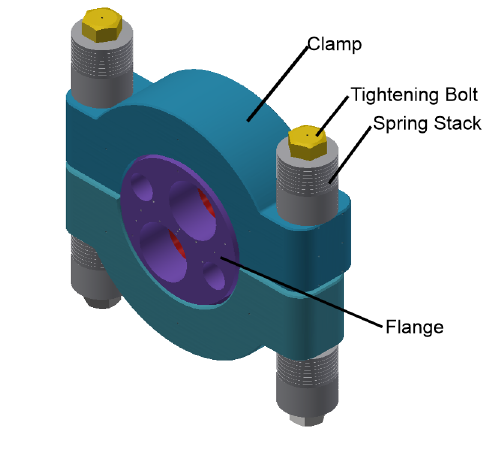
Figure 6. Design of mechanical pipe connection after first